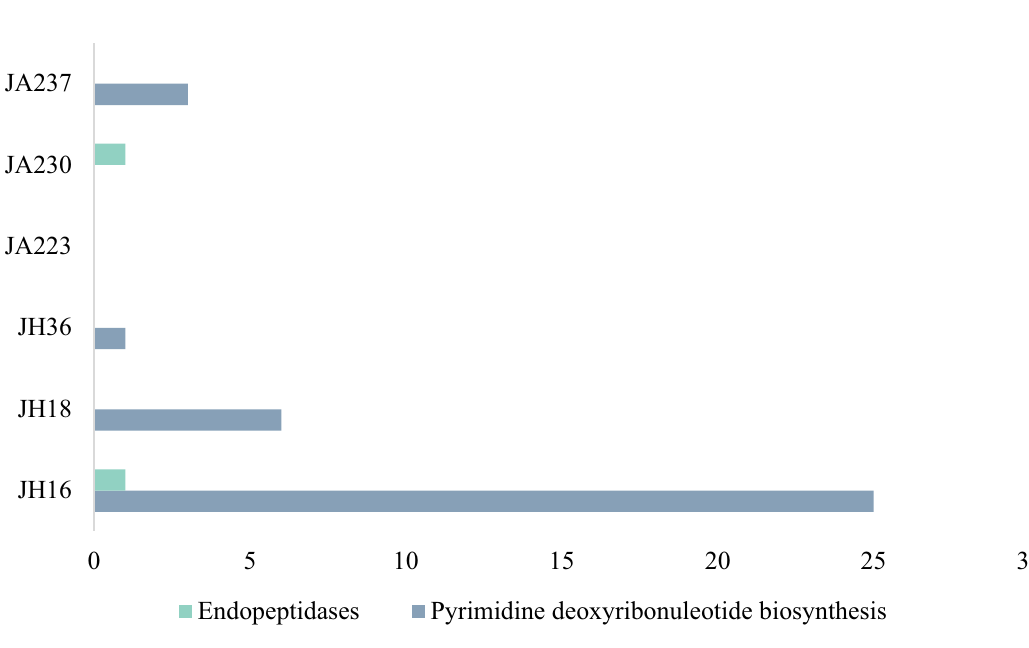
Figure 4. Auxiliary Metabolic Genes in the Virome of six Orang Asli. Three individuals from Jakun Orang Asli (JA223, JA230, JA237) and three individuals from Jehai Orang Asli (JH16, JH18,